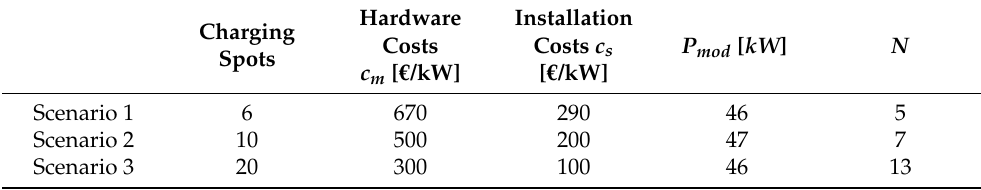
Table 3. Charging spots and costs variations.